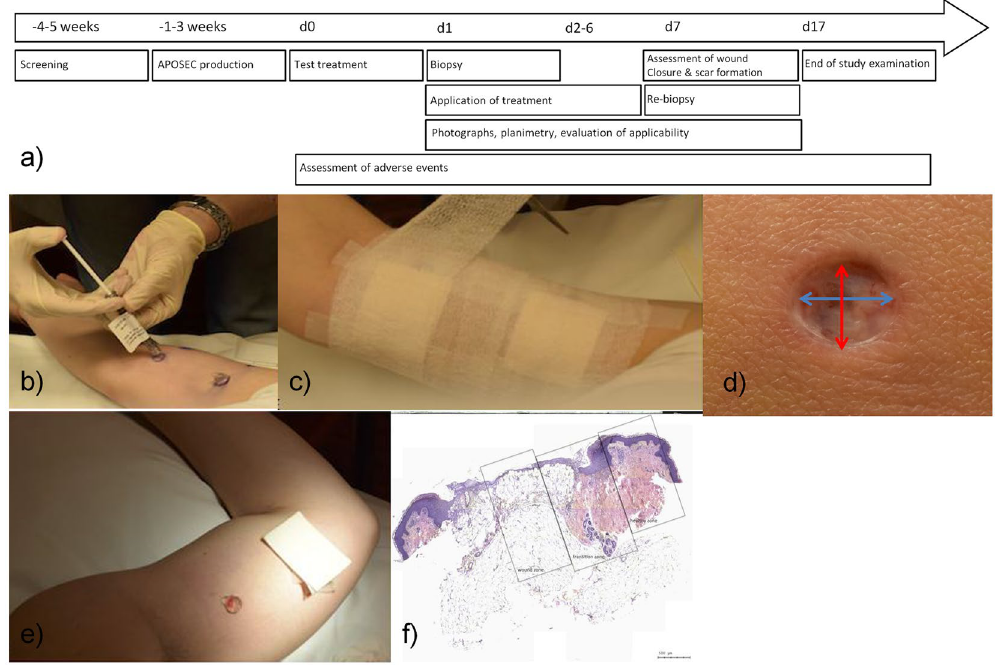
Figure 3. Study timeline and application of APOSEC/placebo. Study timeline ( a ). Application of APOSEC/ placebo on intact skin (test treatment) ( b ). Bandaging of study site ( c ). Maximal (blue line) and minimal (red line) diameter of biopsy wound ( d ). Applied IMP/placebo on artificial wound ( e ). Tissue sample from day 7, boxes show wound, transition, and healthy zones in which measurements were performed ( f